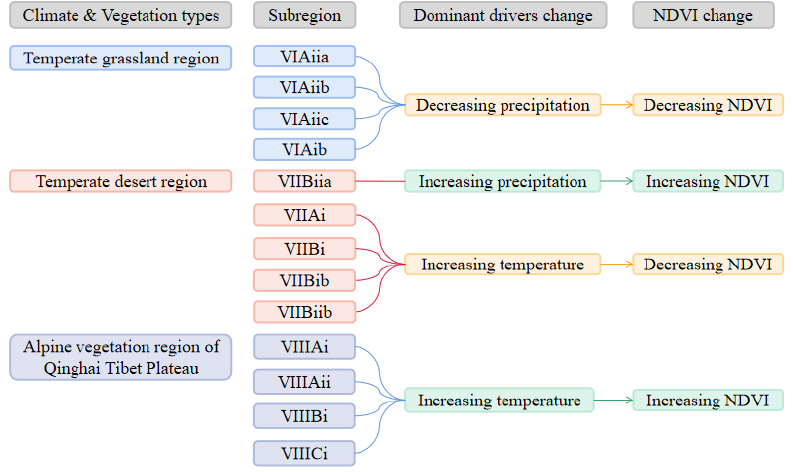
Figure 11. Response of NDVI to change of temperature and